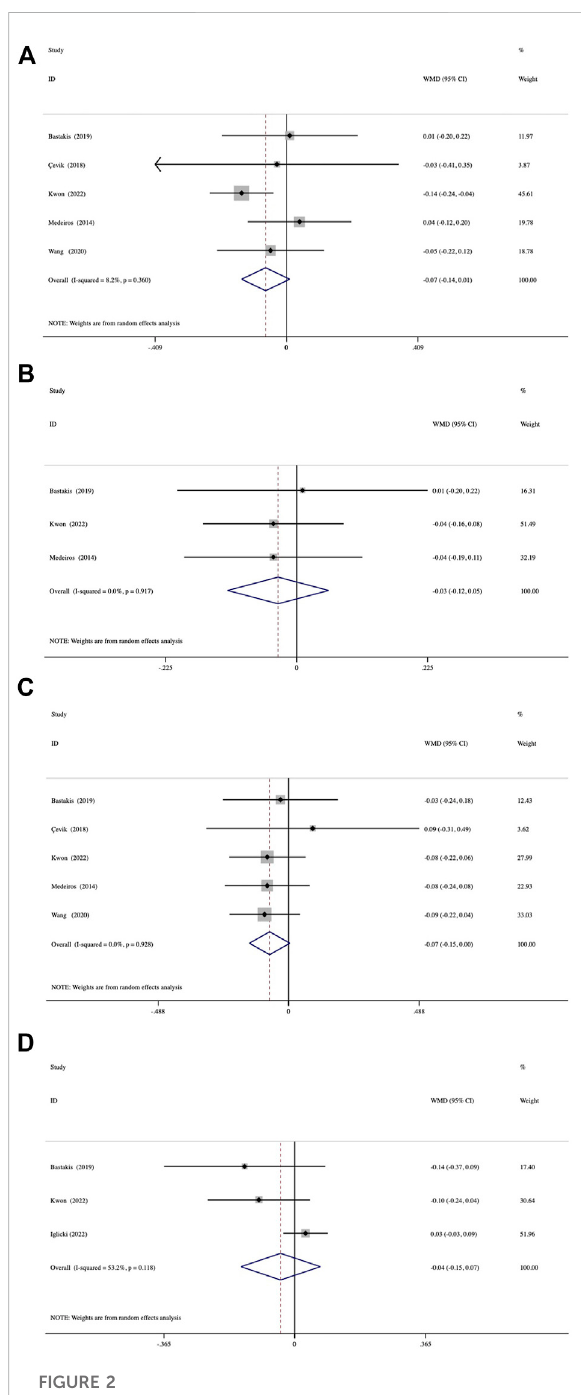
Forest plots of the comparison of mean BCVA (best- corrected visual acuity) improvement between the vitrectomized and nonvitrectomized groups (A) 1 month, (B) 3 months, (C) 6 months, and (D) 12